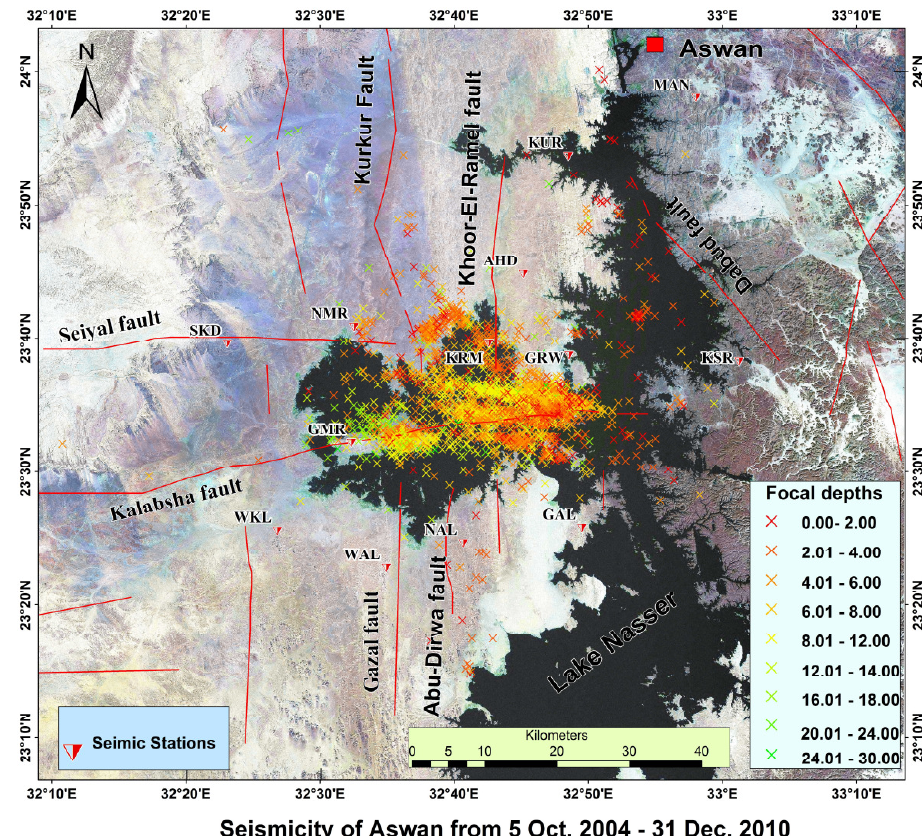
650 Fig. 1 651 Fig. 1. Seismicity of the Aswan area (Egypt) from 2004 to 652